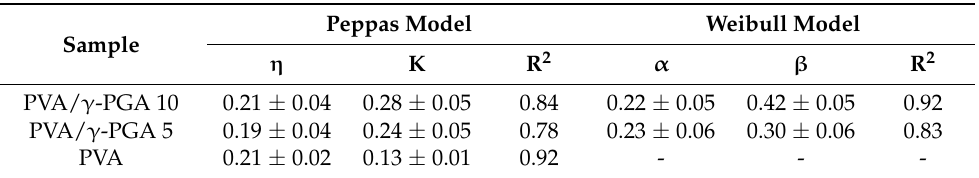
Table 2. Kinetics models parameters of CGA released from loaded PVA, PVA/ γ -PGA 5, and PVA/ γ - PGA 10 fiber